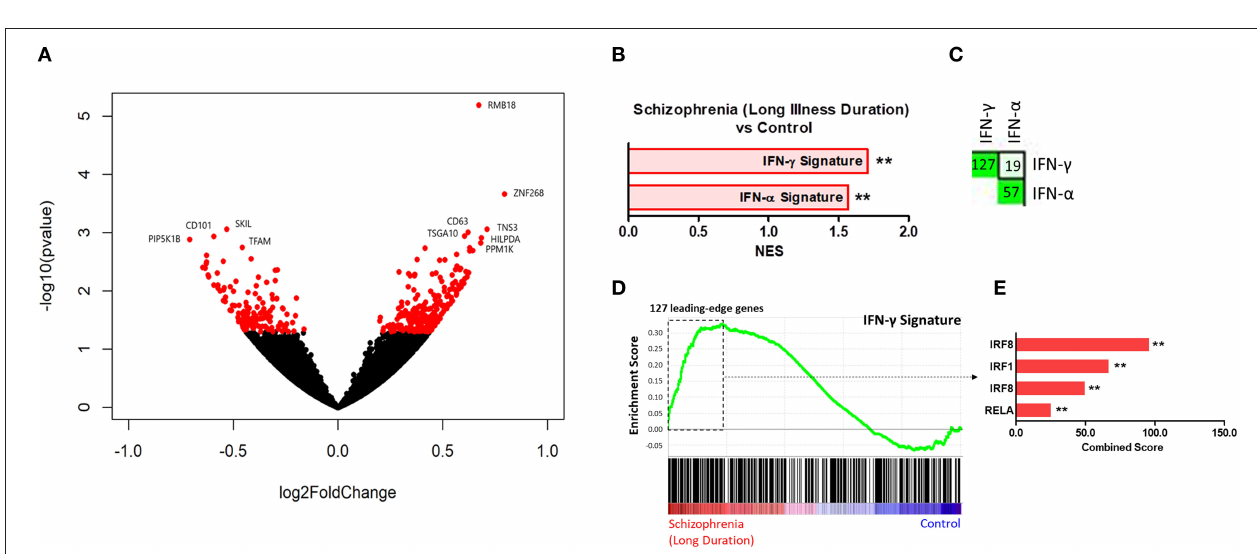
FIGURE 4 | (A) Volcano plot of DGE: long illness duration participants vs. controls. p < 0.05 labeled red. (B) Signatures that were enriched in the long illness duration group compared to controls. **FDR < 0.05, *FDR < 0.25. (C) Leading-edge analysis for signatures enriched amongst genes increased in the long illness duration group compared to controls. The number and green gradient indicate overlapping leading-edge subset genes between the corresponding signatures. (D) Enrichment plot for the IFN- γ signature in the long illness duration group compared to controls. Genes are ranked from greatest increase to the greatest decrease in expression in the long illness duration group compared to controls. Black lines indicate the location of genes that are in both the ranked list and gene set. (E) Top four results from the TFEA of the leading-edge subset genes in the IFN- γ signature. ** p < 0.001 and adjusted p < 0.001.